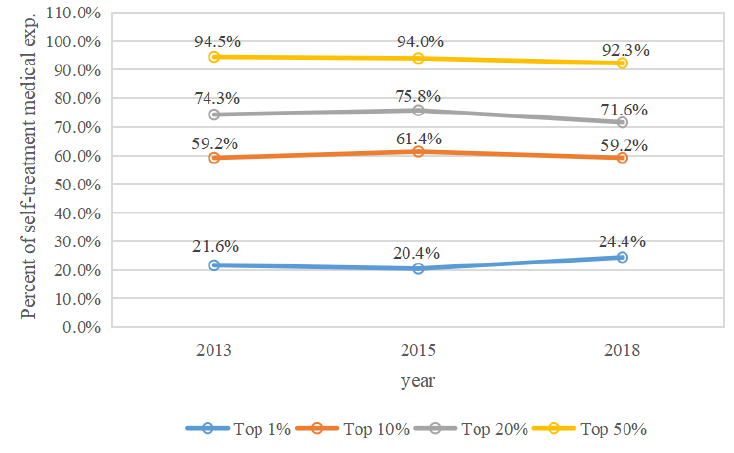
Figure 4. The concentration of self-treatment medical expenses by year. In 2013, 2015, and 2018, middle-aged and elderly people in the top 1% category of total medical expenditures spent 22.0%, 27.9%, and 35.2% of the total annual medical expenses, respectively (Figure 1). Medical expenses for middle-aged and elderly people in the top 10% category accounted for 64.2%, 68.6%, and 76.1% of the total medical costs, respectively. Those with the top 20% of expenditures spent 79.0%, 82.1%, and 85.0% of the total annual medical expenses, respectively, while the share of spending on the total medical expenditures of those with expenses in the top 50% was above 95% in 2013, 2015, and 2018. The proportion of total medical expenses spent by the top 1%, 10%, 20%, and 50% of middle-aged and elderly spenders increased over